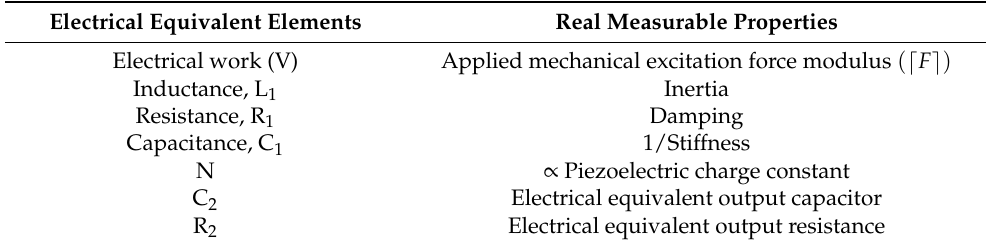
Table 1. Equivalences between the measurable properties, electrical and mechanical, based on the Butterworth Van Dyke equivalent circuit.